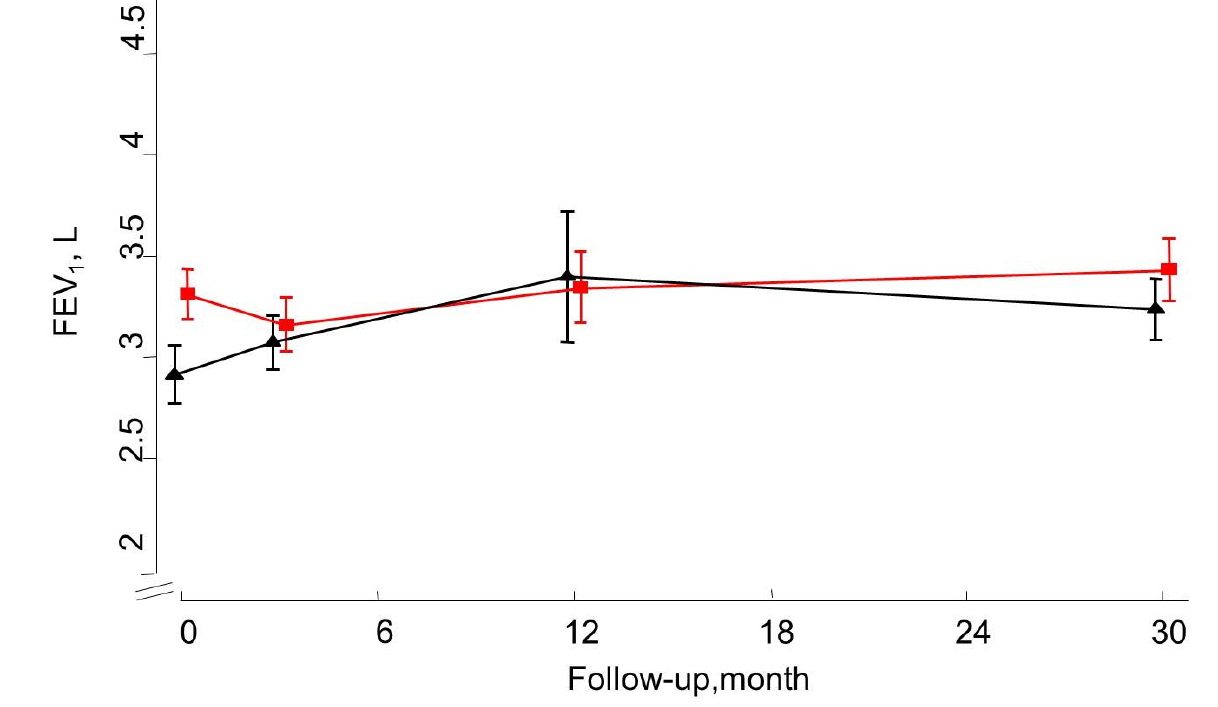
Figure 7. Mean FEV1 for the Internet and Usual care group as measured at 0, 3, 12, and 30 months of